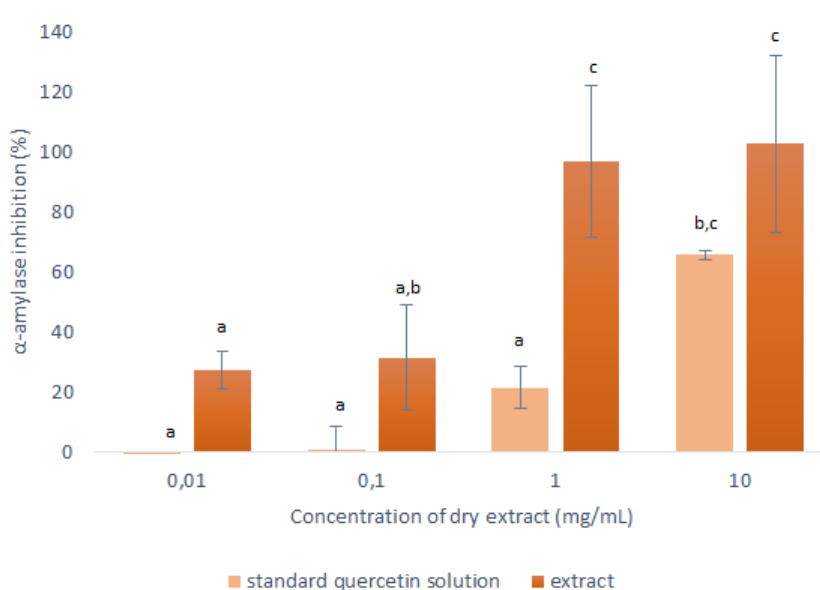
Figure 6. Anti- α -amylase activities of the dry matter from the concentrated 50% ethanol extracts (1:10 mass-to-liquid ratio, 25 ◦ C; 15 min) and the corresponding stock solution of the quercetin standard, in terms of inhibition of α -amylase activity. Data are means ± standard deviation and di ff erent letters indicate significant di ff erences ( p < 0.05;